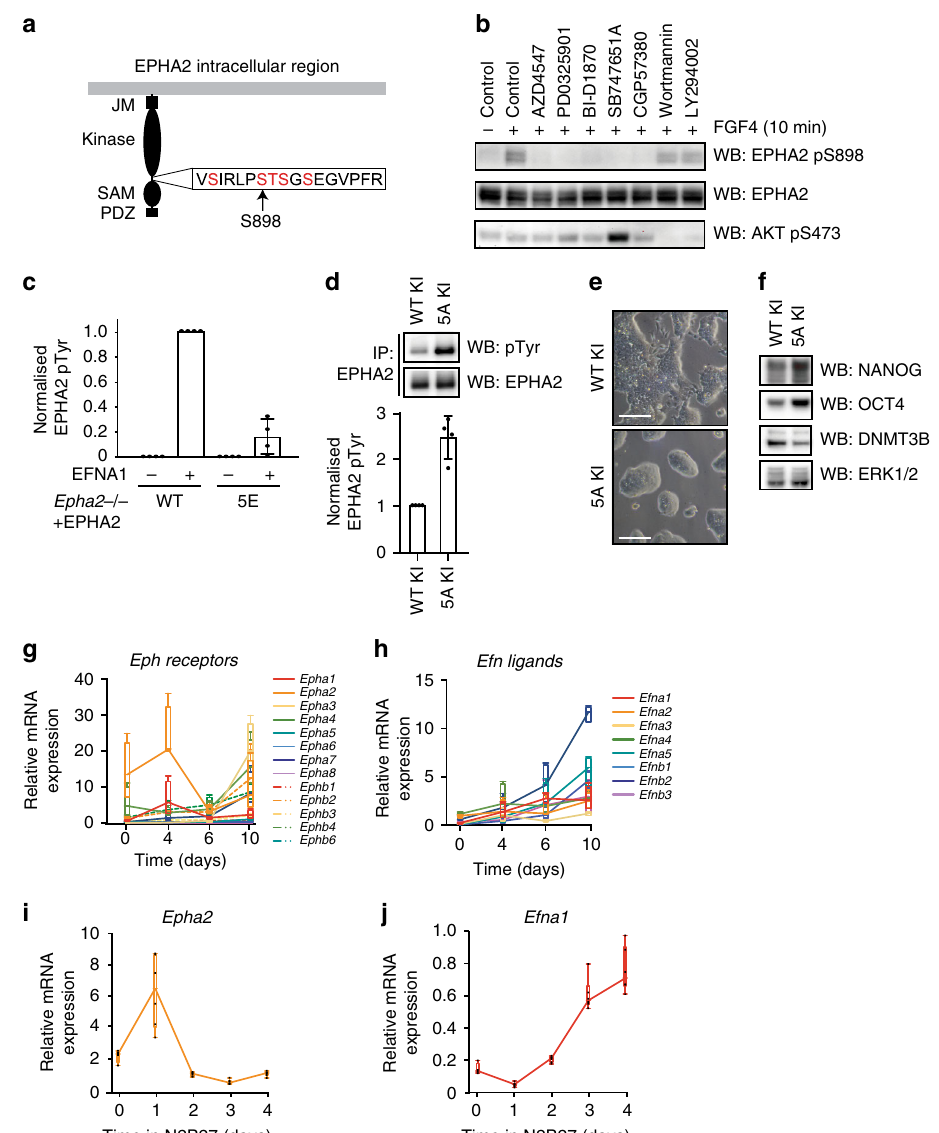
Fig. 4 FGF4 – ERK1/2 signalling inhibits EPHA2 activation and rewires EPH – EFN expression. a Diagram of potential phosphorylation sites within the EPHA2 S898 motif. Mass spectrometry analysis detects phosphorylation of at least three sites in EPHA2 immunoprecipitated from FGF4-stimulated Fgf4 − / − mESCs (see Supplementary Table 1). b Fgf4 − / − mESCs were treated with 10 μ M of the indicated inhibitors for 1 h, and stimulated with FGF4 for 10 min. EPHA2 pS898, EPHA2 and AKT pS473 levels were determined by immunoblotting. c Epha2 − / − mESCs were transfected with either wild type or 5E EPHA2 constructs, and stimulated with 1 μ g/ml clustered EFNA1 for 15 min. EPHA2 was immunoprecipitated, and pTyr and EPHA2 levels determined by immunoblotting and quanti fi ed. Data show mean ± SD ( n = 4). d EPHA2 was immunoprecipitated from EPHA2 WT knock-in (KI) or 5A KI cell lines and pTyr and EPHA2 levels determined by immunoblotting (upper panel). Relative pTyr/EPHA2 signal was quanti fi ed (lower panel). Data show mean ± SD ( n = 4). e Phase-contrast images of EPHA2 WT KI or 5A KI mESC lines; scale bar = 100 µ M. f EPHA2 WT KI or 5A KI cell lines were cultured in LIF/FBS medium for 48 h, and KLF4, NANOG, DNMT3B, OCT4 ppERK1/2 and ERK1/2 levels determined by immunoblotting. g Epha2 + / + mESCs were differentiated as embryoid bodies for 10 days, and EPH receptor expression determined by qRT-PCR at the indicated time points. Box-and-whisker plots show median, fi rst and third quartiles, and maximum and minimum values of four technical replicates ( n = 4). h Epha2 + / + mESCs were differentiated as embryoid bodies for 10 days, and EFN ligand expression determined by qRT-PCR at the indicated time points. Box-and-whisker plots show median, fi rst and third quartiles, and maximum and minimum values of four technical replicates ( n = 4). Epha2 ( i ) and Efna1 ( j ) mRNA expression in 2i mESCs undergoing differentiation in N2B27 was determined by qRT-PCR analysis at the indicated time points. Box-and-whisker plots show median, fi rst and third quartiles, and maximum and minimum values of two technical and three biological replicates ( n = 3). Source data are provided as a Source Data fi